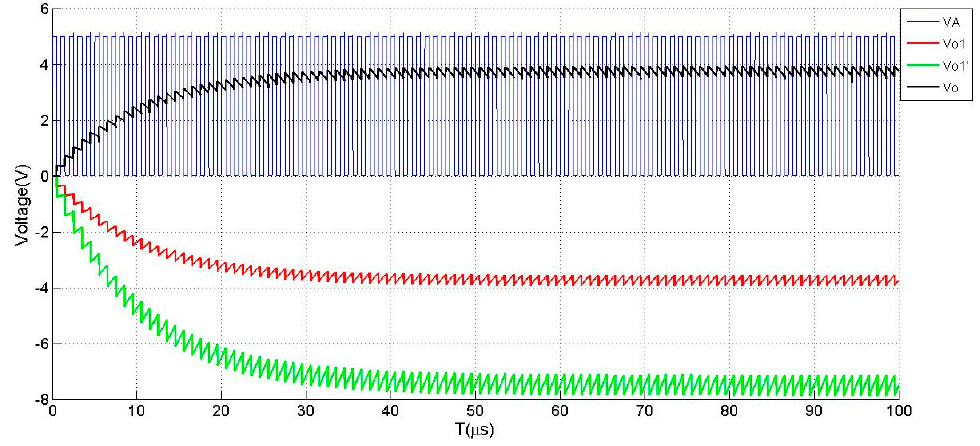
Figure 14. Simulated output of the differential charging and discharging circuit in Figure 14.